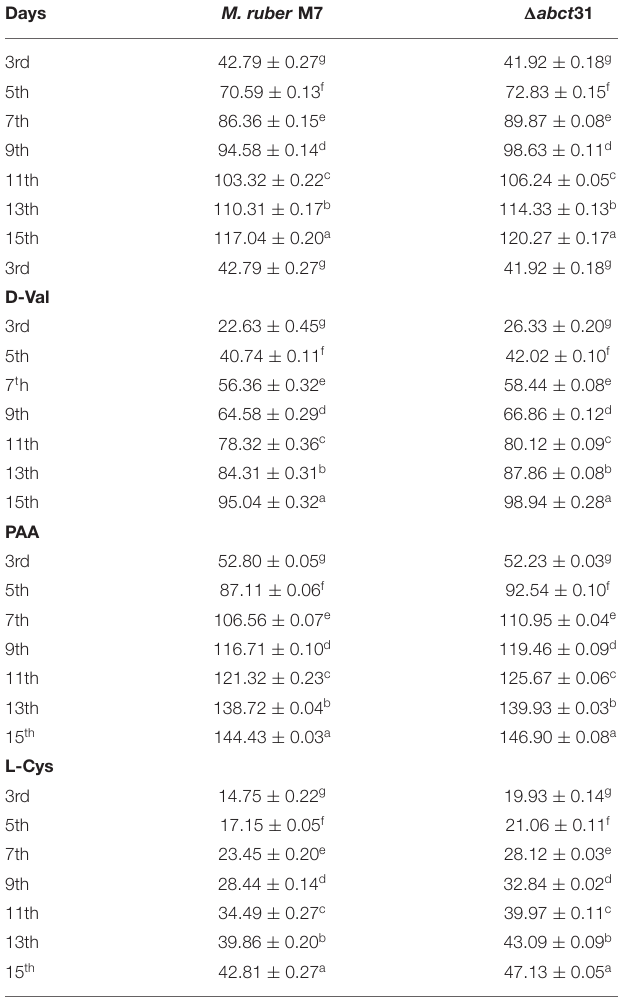
TABLE 4 | Comparison of pigments production of M. ruber M7 and 1 abct 31 feeding D-Val, PAA, L-Cys.